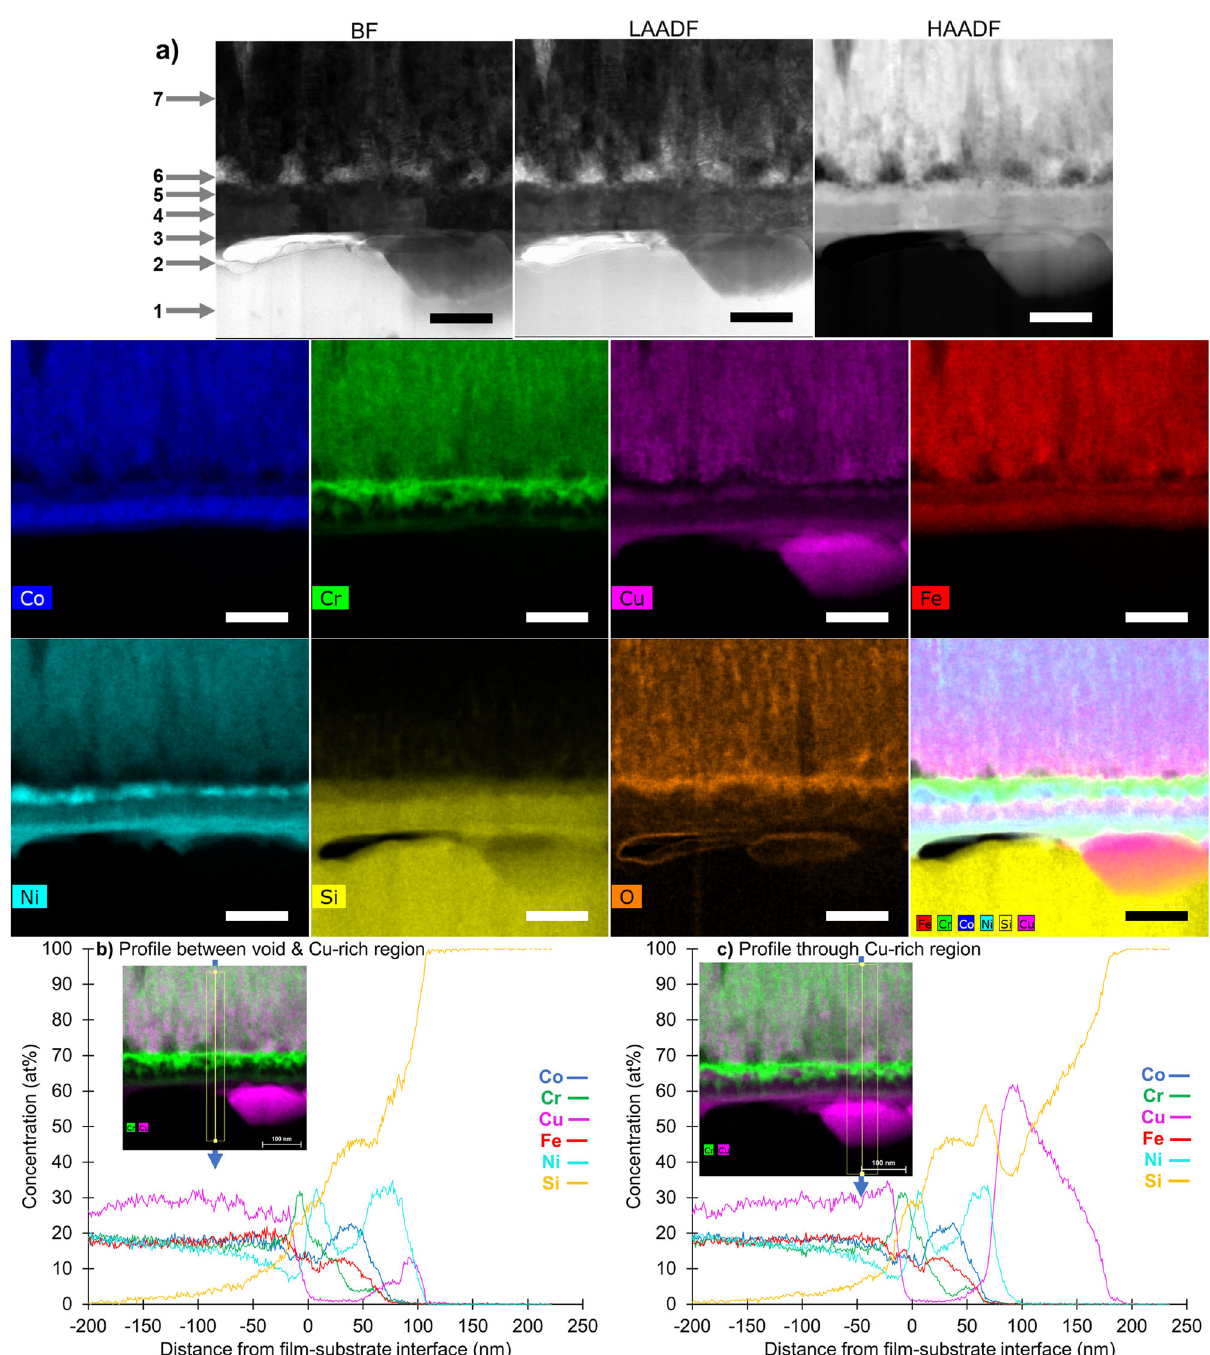
Fig. 7 The interface between the HEA fi lm and Si substrate continues to evolve and form a multilayered structure with a higher Au-ion irradiation dose. a STEM-BF, LAADF, and HAADF images and EDS maps of the CoCrCuFeNi fi lm grown on a Si substrate after room temperature 11.5 MeV Au-ion irradiation to a fl uence of 7.1 × 10 14 cm − 2 ((peak of ~6.1 dpa). Arrows in a highlight the seven regions that are observed. The scale bar length in all images is 100 nm. Concentration pro fi les normal to the interface b next to and c through the Cu-rich silicides also form in the same order under room temperature ion core of the nanoparticles 41 . The order of preference for formation irradiation. Low temperature irradiation seemingly is enough to of oxides in these nanoparticles follows that of the formation resemble that of high temperature exposure in this system, energy of the separate oxide. The formation of these multiple highlighting the effective driving force of radiation-induced silicide phases resembles the formation of various oxide phases diffusion rather than the thermal-induced diffusion that is based during high temperature oxidation of HEA alloys, which are on temperature-dependent vacancy concentration. Further accompanied by substantial oxide scale thicknesses depending on research into very low temperature or cryo-irradiation conditions composition 11 . Similarly, here the metals that most readily form